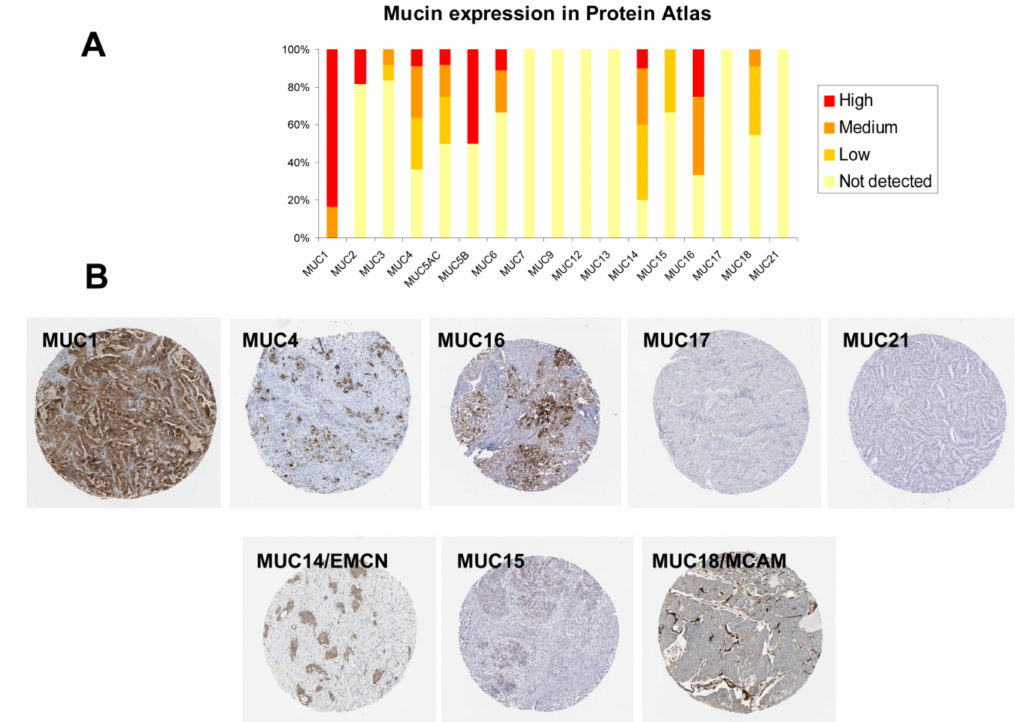
Figure 8. Detection of mucin expression by immunochemistry in human pancreatic cancer human tissue. ( A ) Histogram of mucin expression in PDAC samples from Protein Atlas (www.proteinatlas.org /